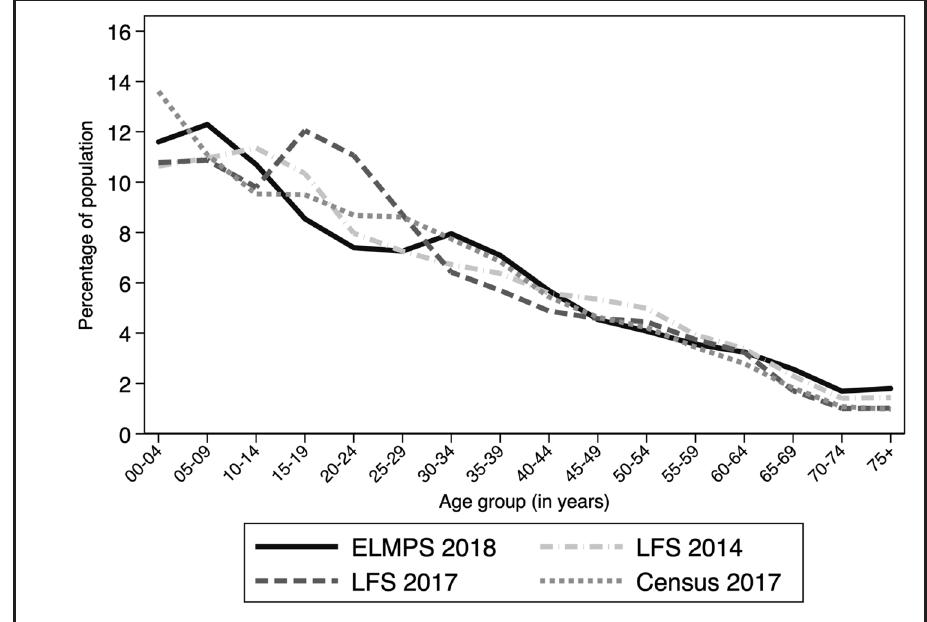
Comparison of age distribution (percentage in 5-year age group), by data source.